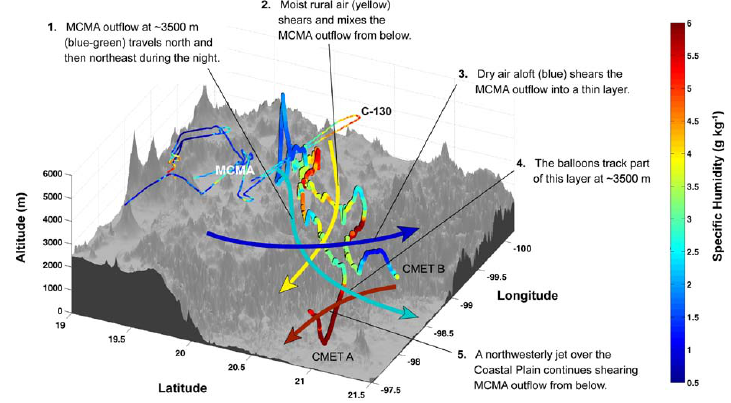
Fig. 9. CMET balloon trajectories on 18–19 March, colored by the observed specific humidity, leave Mexico City and extend jaggedy towards the viewer in the foreground. A portion of the 18-March C-130 flight, which occurred just before the balloon launch, is shown by the thin colored line in the background. The arrows, also colored by specific humidity, show the overall flow as inferred from the balloon soundings. The sheared layer of MCMA outflow forming here (blue-green arrow) is part of a much larger layer of MCMA outflow that spread over the Gulf of Mexico on 19 March and was intercepted several times by MILAGRO aircraft.